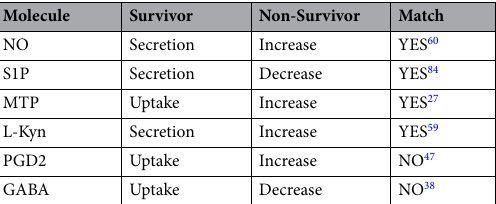
Table 3. Biomarker mean exchange directions and relative levels compared between sepsis survivor and non- survivor models. Nitric oxide (NO), 5 meth-oxy-tryptophan (MTP), L- kynurenine (L-kyn),